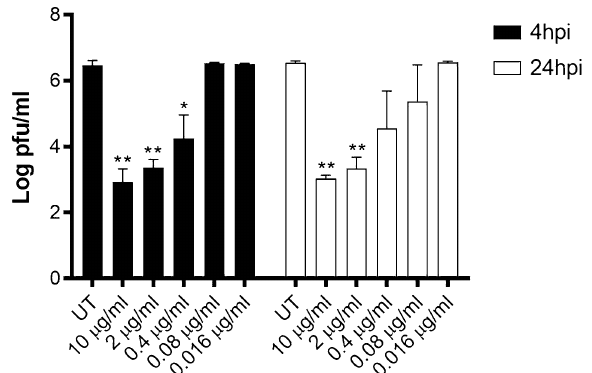
Figure 3. Viral yield reduction assay. Vero-E6 were infected with SARS-CoV-2 (MOI 0.005). 4 h or 24 hpi, medium containing or not serial dilutions of MB was added on cells. 24 h later, cell supernatants were collected and titrated on Vero-E6 cells as described in Fig. 2. Results are mean and SD of two independent experiments performed in duplicate. *p < 0.05, **p <